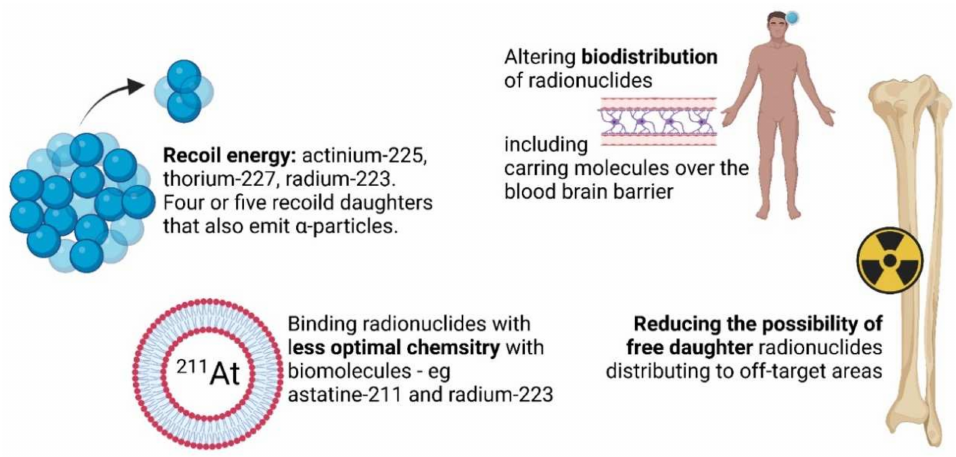
Figure 1. Shortcomings in TAT and addressing strategies using